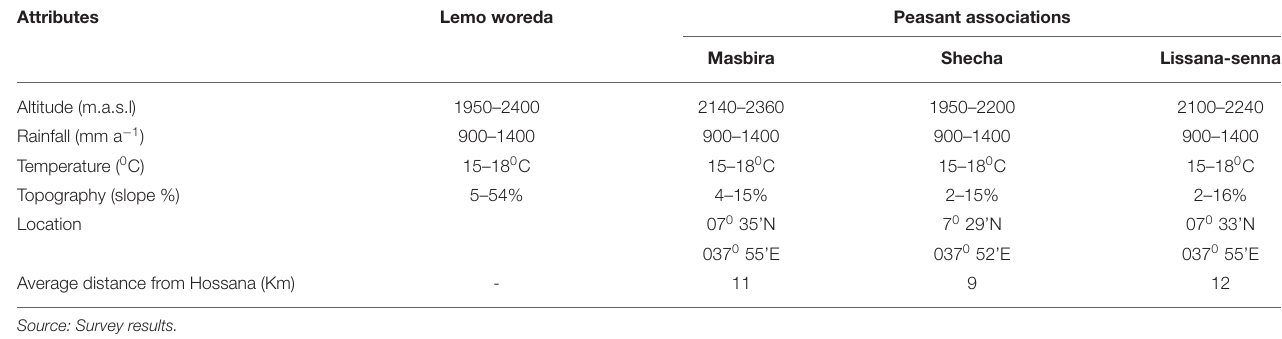
TABLE 1 | Biophysical information. Attributes